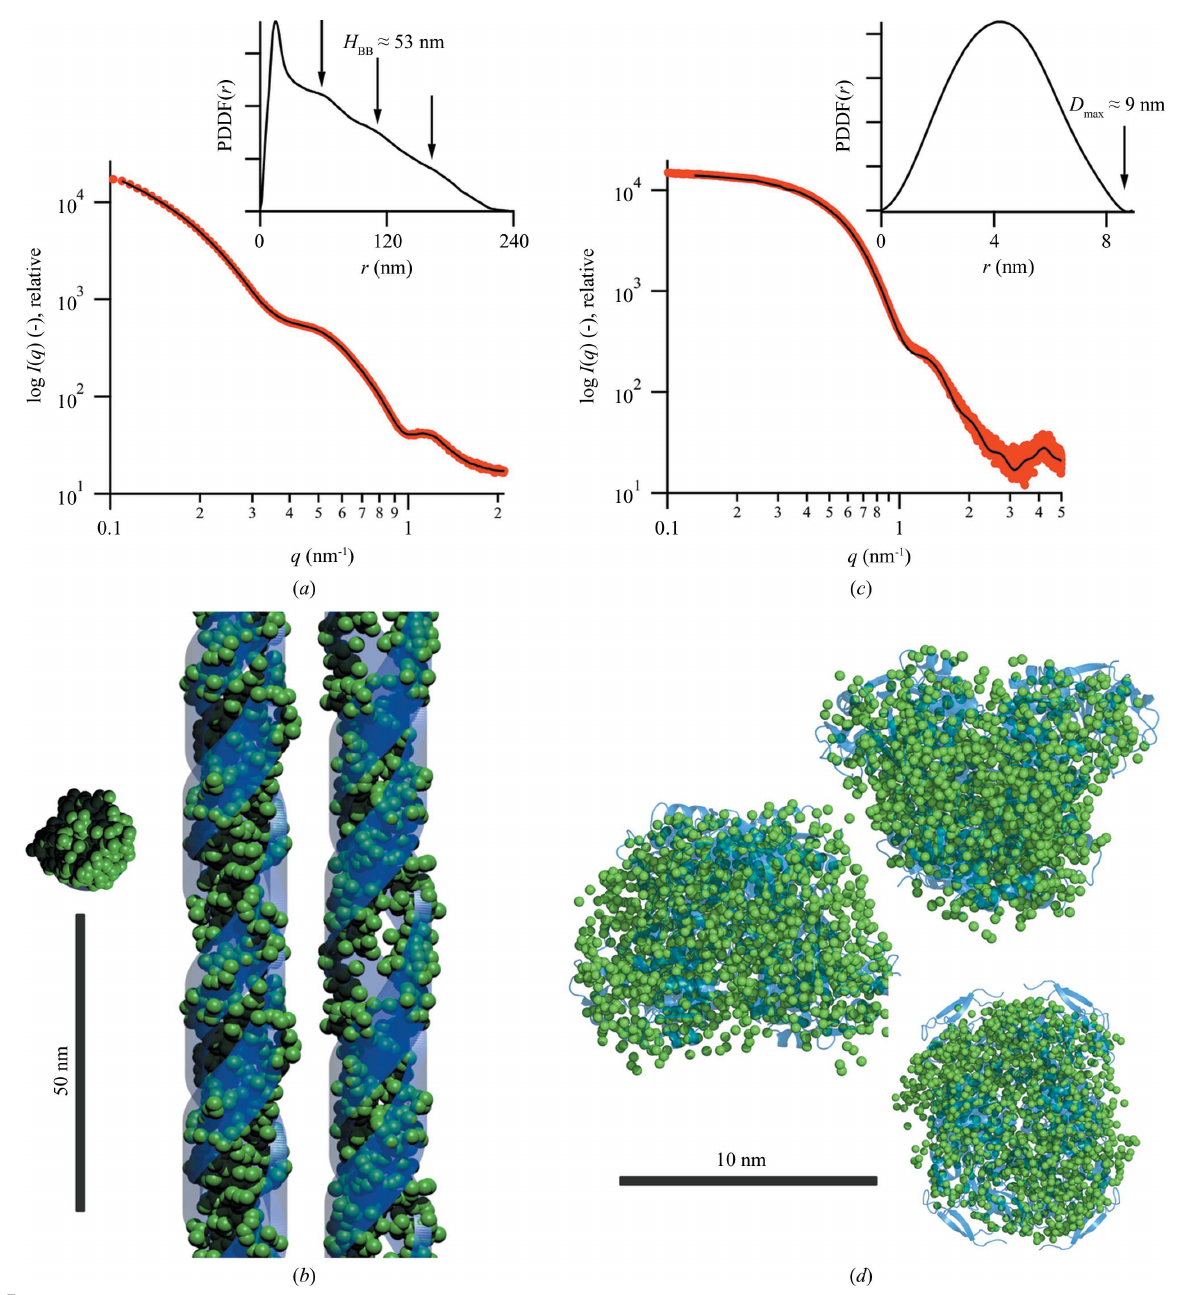
Figure 5 Verification of the reconstruction algorithm using experimental scattering data. ( a ) Experimental scattering data (error bars omitted for clarity) and fitted curve from the reconstruction of the self-assembled peptide double helix. The corresponding PDDFis shown in the inset, whereas the dPDDF used to determine the stacking distance can be found in Fig. S13. ( b ) Orthogonal views of the model reconstructed from the scattering pattern in panel ( a ) (green) compared with the previously published structure (blue). ( c ) Experimental data, fitted curve and PDDF for alcohol dehydrogenase 1 (ADH). ( d ) Orthogonal views of the model reconstructed from the scattering pattern in panel ( c ) (green) compared with the crystal structure model (blue). See Fig. S17 for point representations of the reconstructions shown in panels ( b ) and ( d ), and Fig. S18 for a numerical stability analysis of both